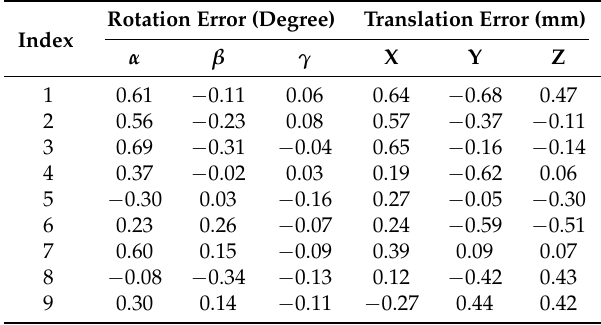
Table 2. The measurement error of workpiece in the first station.